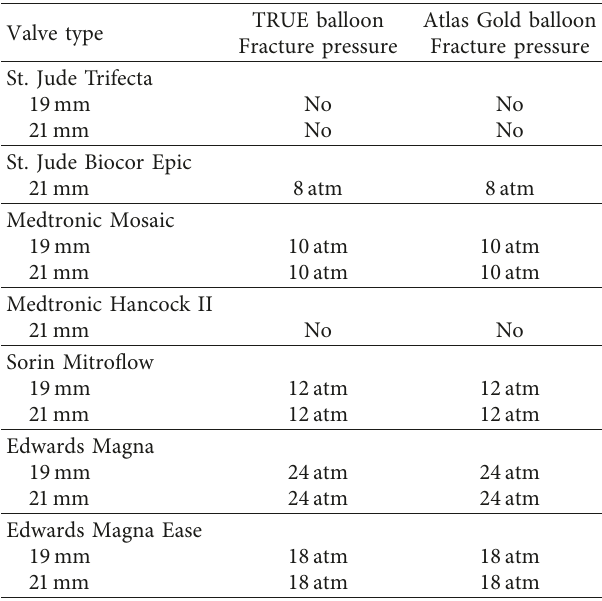
Table 1: Balloon fracture pressures according to Allen et al., 2017 [15]. In this study, the balloon was sized 1mm larger than the valve size. atm,